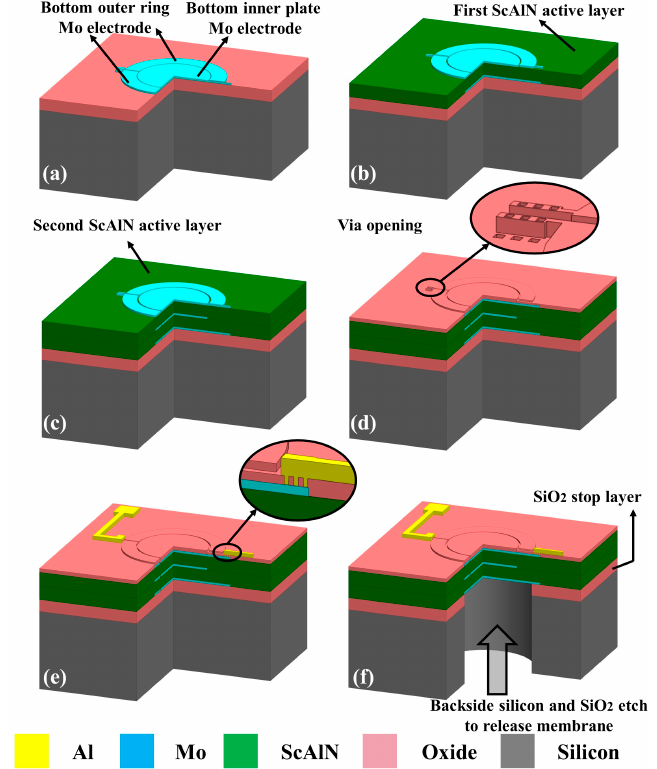
Figure 5. The illustration of the process flow (( a – f ) in sequence) for the fabrication of bimorph dual-electrode ScAlN PMUT: ( a ) bottom Mo electrode sputtering and patterning; ( b ) first active ScAlN and middle Mo electrode sputtering, middle Mo electrode patterning; ( c ) second active ScAlN and top Mo electrode sputtering, top Mo electrode patterning; ( d ) PECVD SiO 2 deposition and via etching; ( e ) metallization to complete the interconnection of PMUT; ( f ) backside silicon and SiO 2 etch to release membrane.